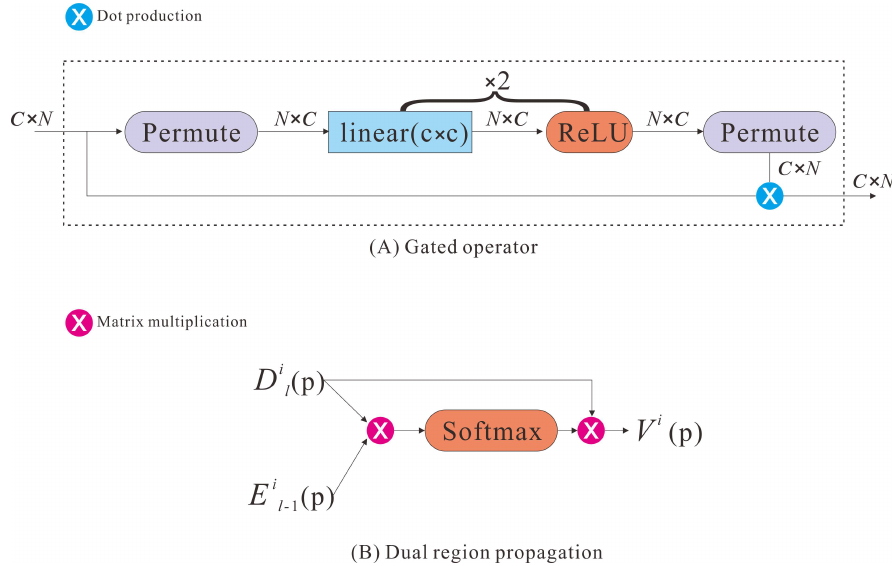
Figure 5. The detailed structure of ( A ) the gated operator and ( B ) dual region propagation. The input of our gated operator is with dimension of C × N . SGFANet utilizes it in three features, e.g., D l ( p ) , D l − 1 ( p ) and V i ( p ) . The dual region propagation is a kind of self-attention mechanism, for projecting ( p ) and E i ( p ) to one-feature the feature D i l l − 1